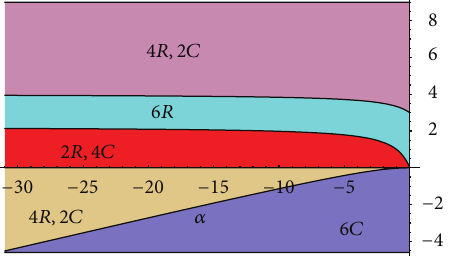
Figure 5: Critical points in the (𝛼,𝑐) -plane for 𝛼 < 0